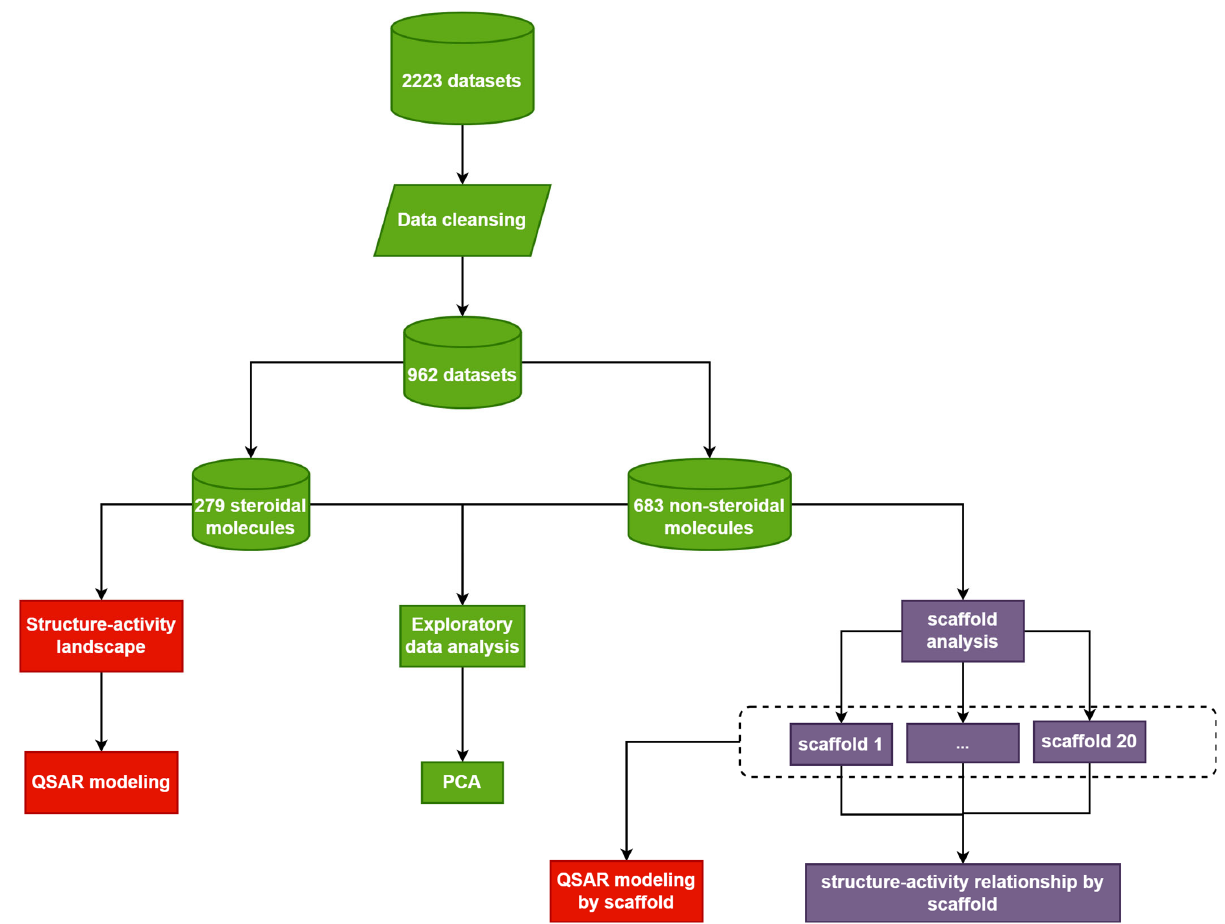
Figure 7. Schematic diagram of the study. Different colors represent different stages of the study: green for data compilation and visualization, red for structure–activity relationship/QSAR, and pur ‐ ple for scaffold analysis.